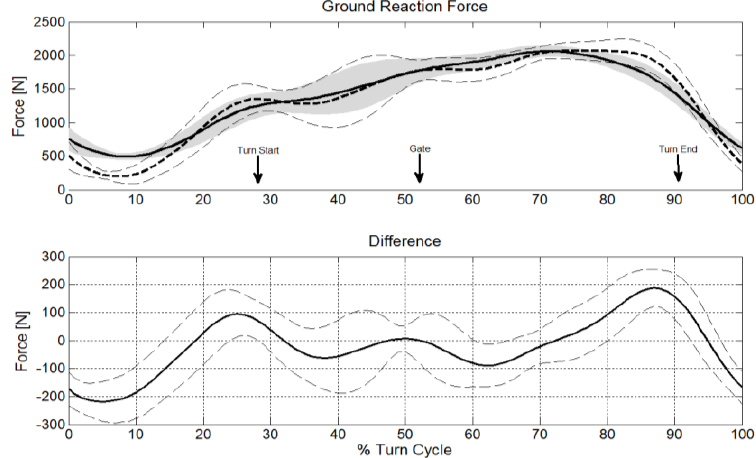
Figure 4. Comparison of the ground reaction force computed from the dGNSS method ( F , solid line) and the reference system ( F , thick dashed line) with their GRF,dGNSS GRF,REF standard deviations ( F , gray area; F , thin dashed lines) in the upper part of GRF,dGNSS GRF,REF the graph. The bottom part of the graph shows the instantaneous average vectorial difference (solid line) and its instantaneous AVD-Within-SD (dashed lines) across the turn cycle. Gate passage and the points where the turn radius is less than 30 m are marked as turn start and turn